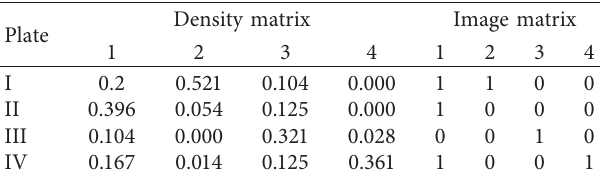
Figure 5: Spatial distribution of the subgroup in the urban CO 2 emission network. Note: (a, c) the spatial distribution of different plates within the geographical space and cyberspace, respectively, and (b) the parameter attribute and CO 2 emissions of each plate. Table 1: Density matrix of the CO 2 emissions on spatial correlation network plate and image